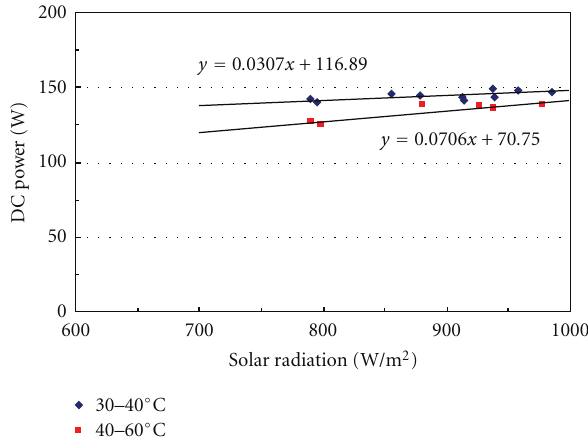
Figure 9: Electrical power of the unglazed PVT collector as a function of solar radiation and temperature.